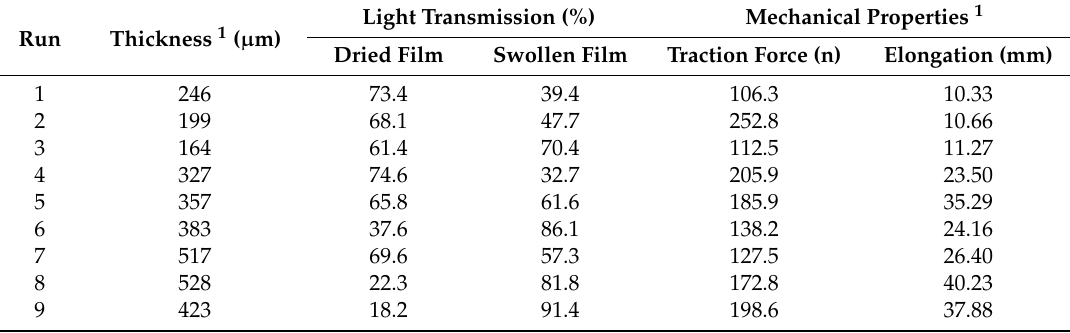
Table 4. Results for thickness, optical and mechanical properties from CGP/PVA films produced using the 3 3-1 fractional factorial